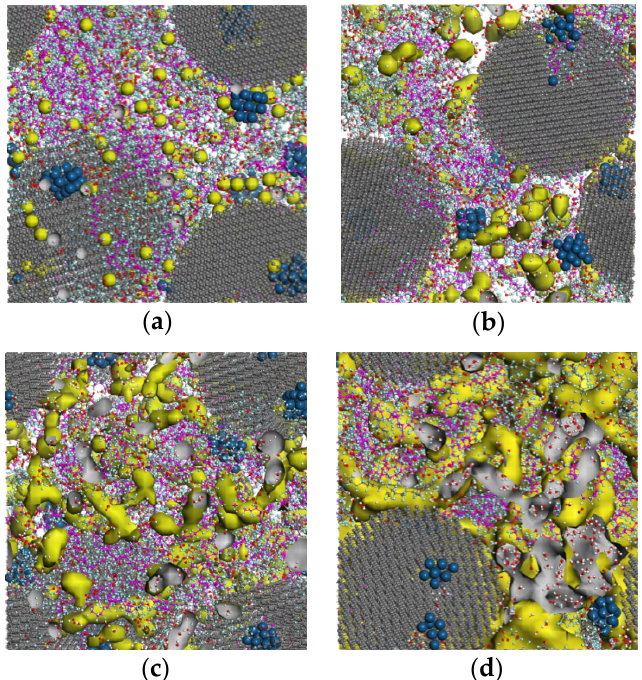
Figure 8. Water distribution and cluster form in catalyst layer (CL) at different water contents: ( a ) water clusters distribution at λ = 1; ( b ) water clusters distribution at λ = 4; ( c ) water clusters distribution at λ = 7; and ( d ) water clusters distribution at λ = 10.